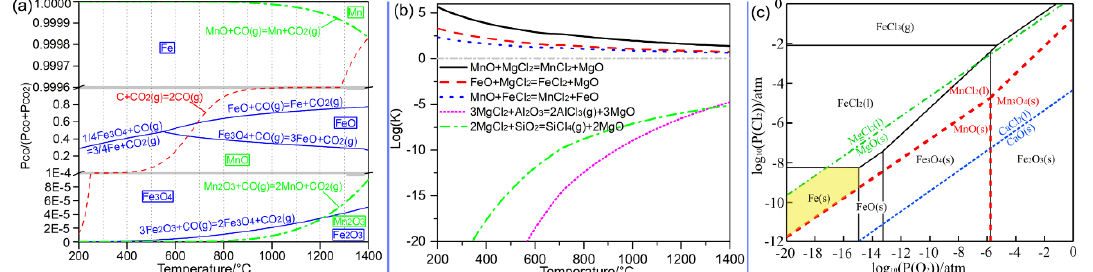
Figure 1. ( a ) Stability diagram for the superimposed Fe–O (solid blue lines) and Mn–O (dash-dotted green lines) systems under CO-CO 2 atmospheres, and CO partial pressure established by the Boudouard reaction (dashed red line). Please note the horizontal grey lines indicates the change of scales for the y -axis. ( b ) Equilibrium constants (in logarithmic form) for the main chlorination reactions as a function of temperature. ( c ) Superimposed (Mn, Fe, Mg, Ca)–Cl–O predominance area diagram at 1000 ◦ C showing the window of opportunity (highlighted in yellow) for simultaneous selective chlorination of MnO and metallization of Fe species.